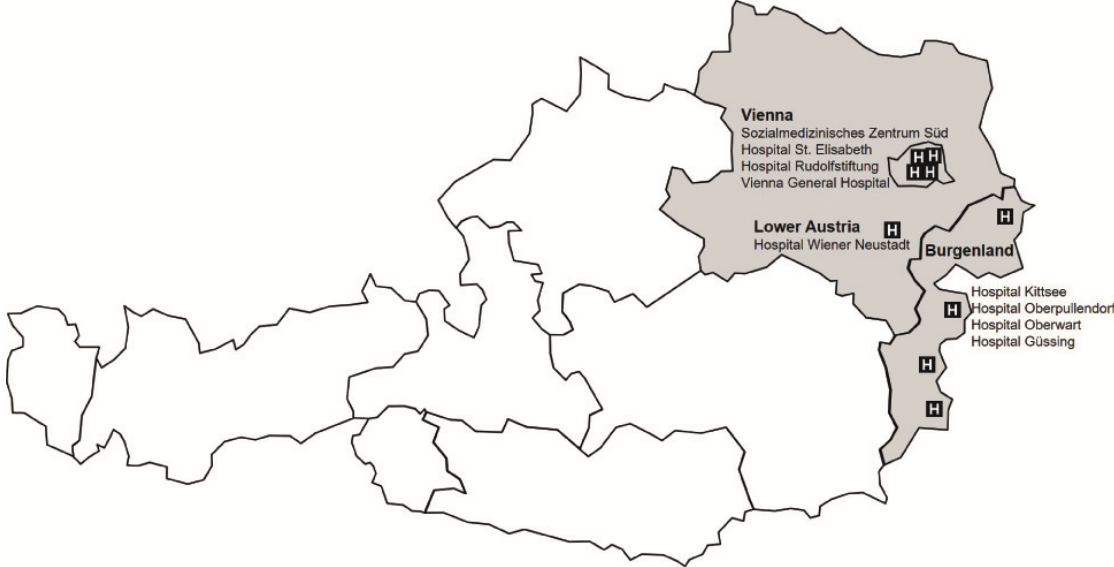
Figure 1. Study sites of CORSA recruitment in Vienna, Burgenland, and lower Austria. Since 2003, more than 13,500 participants have been recruited across nine sites in Austria. Source of illustration: CORSA study team, 2020.